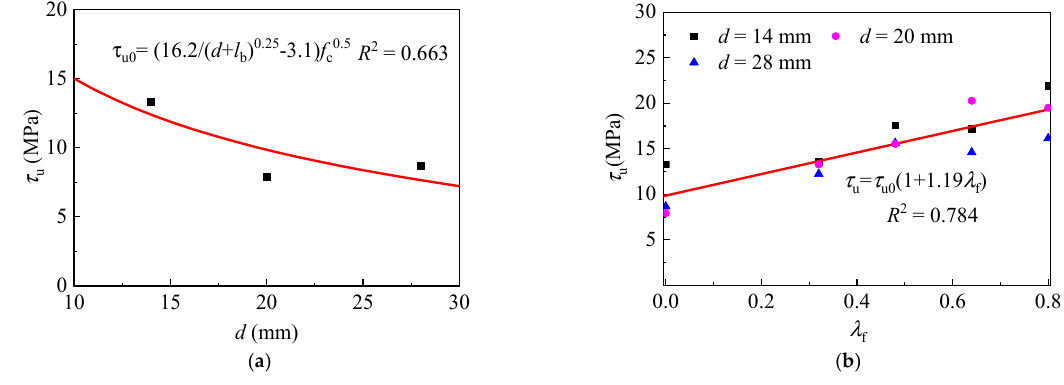
Figure 6. Changes of τ u with factor: ( a ) d ; ( b ) λ f .